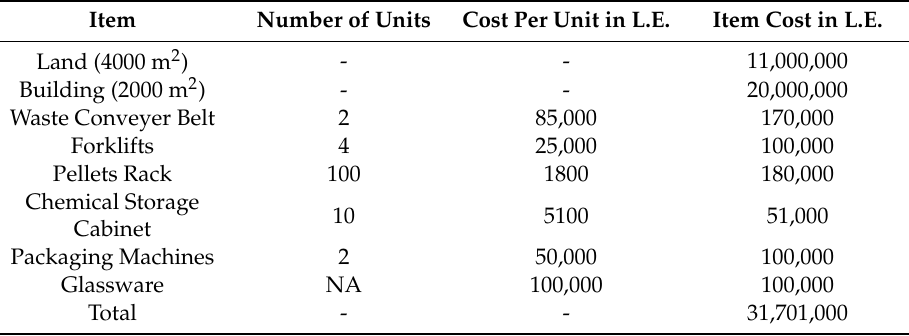
Table 4. Initial investment costs [68].